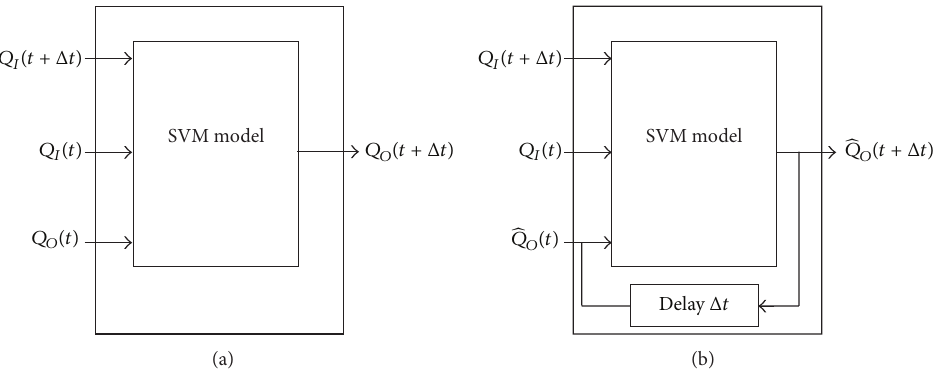
Figure 1: (a) Training phase and (b) prediction